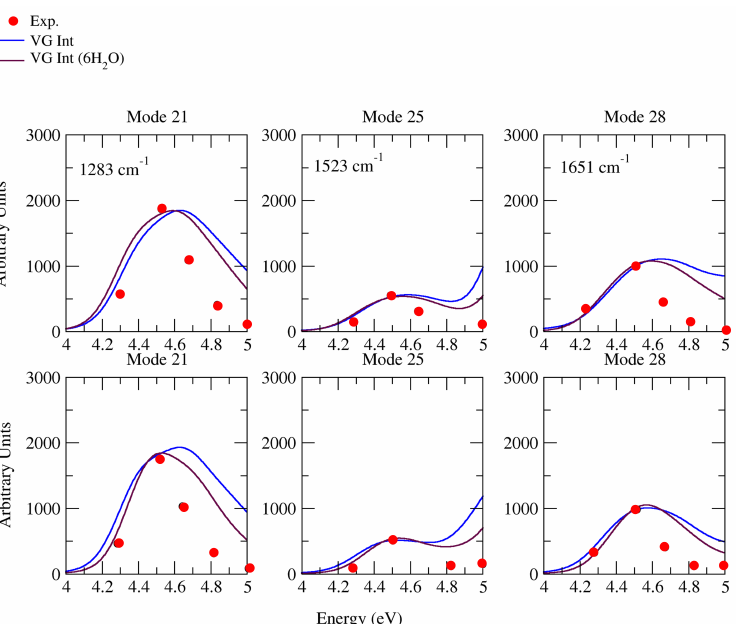
Figure 6. Raman excitation profiles of the four modes of cytosine, computed at VG Int and VG Int , considering the effects of 6H 2 O, convoluted with a Lorentzian with damping γ = 0.04 eV and a Gaus- sian of HWHM = 0.12 eV, calculated by CAM-B3LYP ( top ) and PBE0 ( below ) with the 6-311G+(d,p) basis sets in water. Experimental frequencies are out of parentheses; our computational frequencies are in parentheses. Intensity is renormalized and our computational wavelength of VG Int is blue-shifted by 3629 cm ´ 1 (0.45 eV); VG Int considering the effects of 6H 2 O is blue-shifted by 4839 cm ´ 1 (0.6 eV) for CAM-B3LYP (top); VG Int are blue-shifted by 3629 cm ´ 1 (0.45 eV); VG Int , considering the effects of 6H 2 O, is blue-shifted by 4839 cm ´ 1 (0.6 eV) for PBE0 (below), to match the experiment.